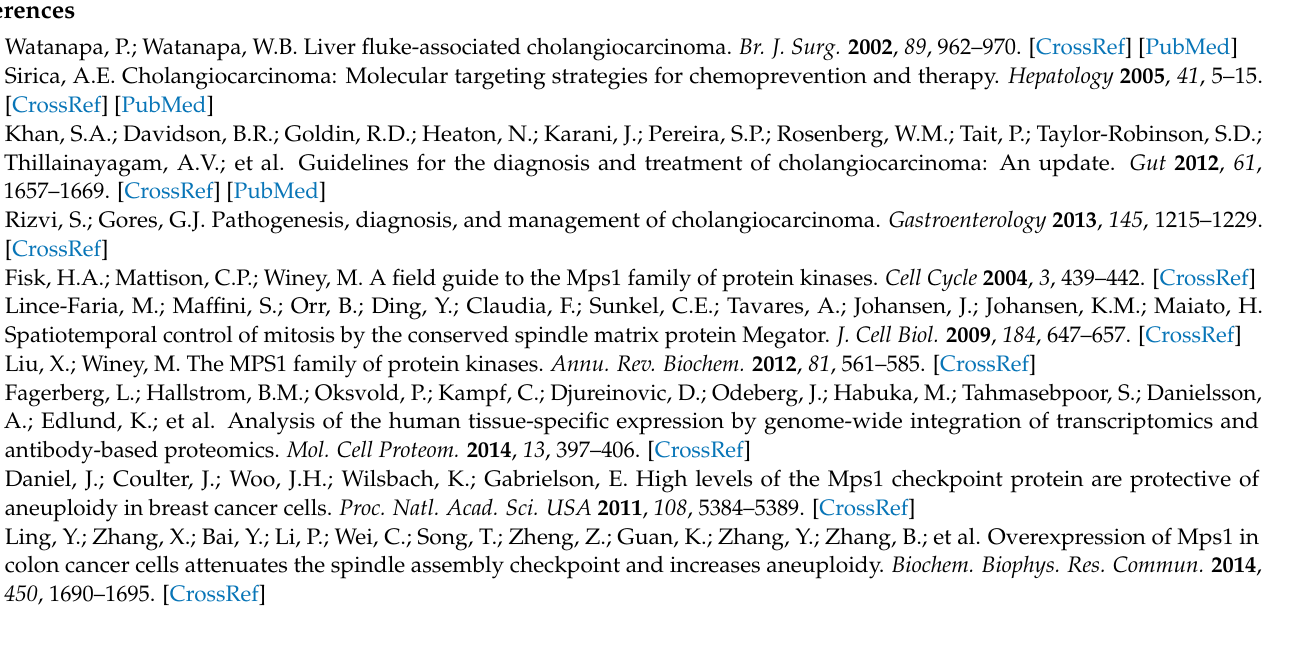
GEPIA and GEO databases. Table S2: MPS1 expression and clinicopathological features of 185 CCA patients, Figure S1: MPS1 protein expression in four CCA cell lines. Figure S2: The expression of Cyclin B1, Mcl-1 and Bax after MPS1 knockdown in CCA cell